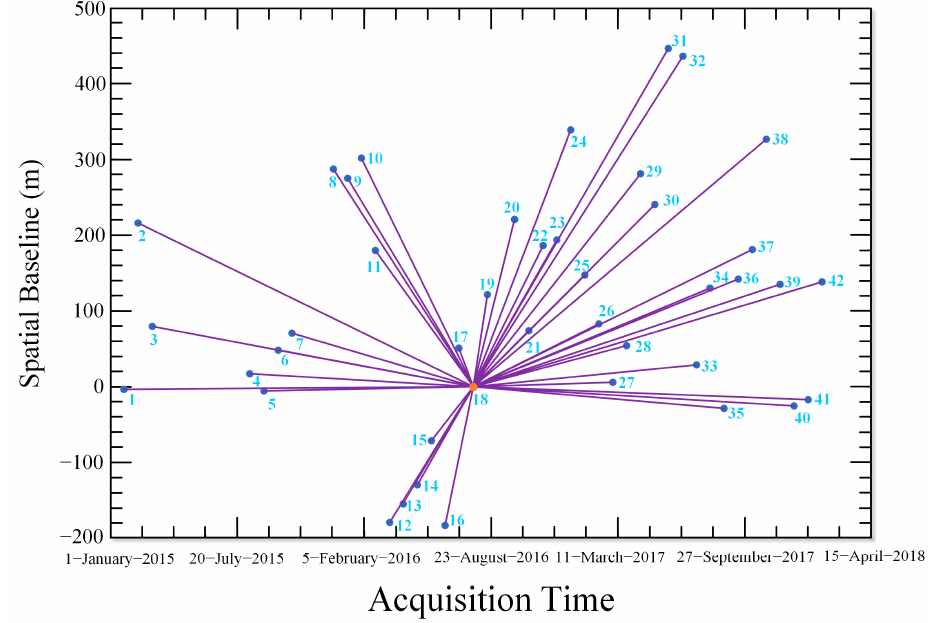
Figure 3. Spatiotemporal baselines of the interferometric pairs (the center orange dot represents the index of master image).